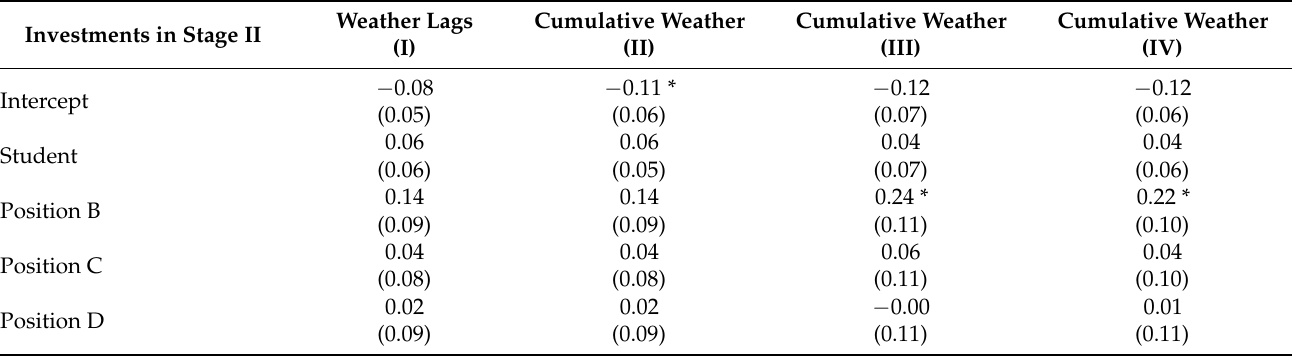
Table 3. Standardized regression results of Stage